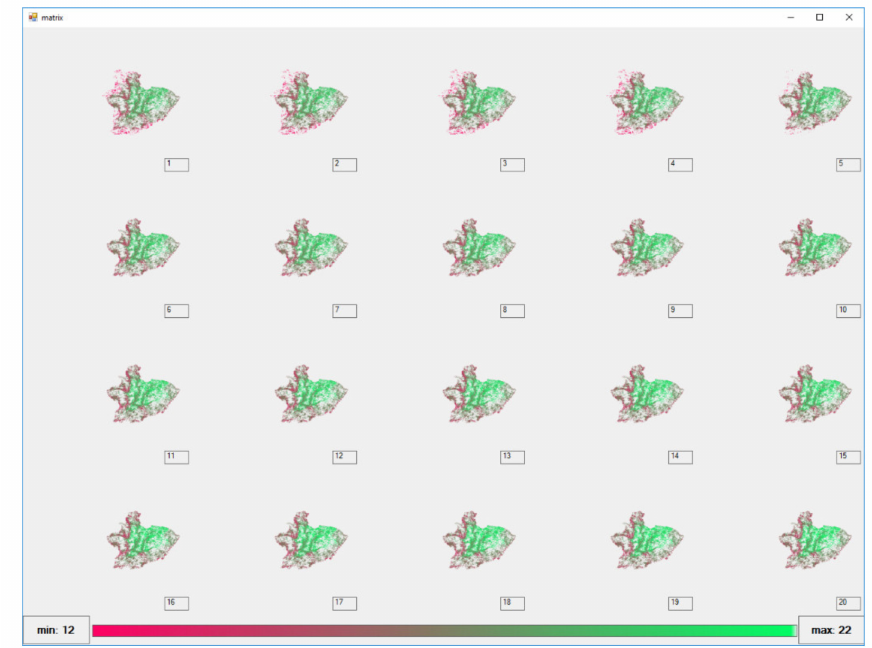
Figure A9. Price distribution for Scenario 1 (Biomass III (B 3 ), felling) over a period of 20 years (t 1 to t 20 ) in the Nordeste region, Portugal. The minimum price was 12 € / m 3 (light red) and the maximum 22 € / m 3 (light green).